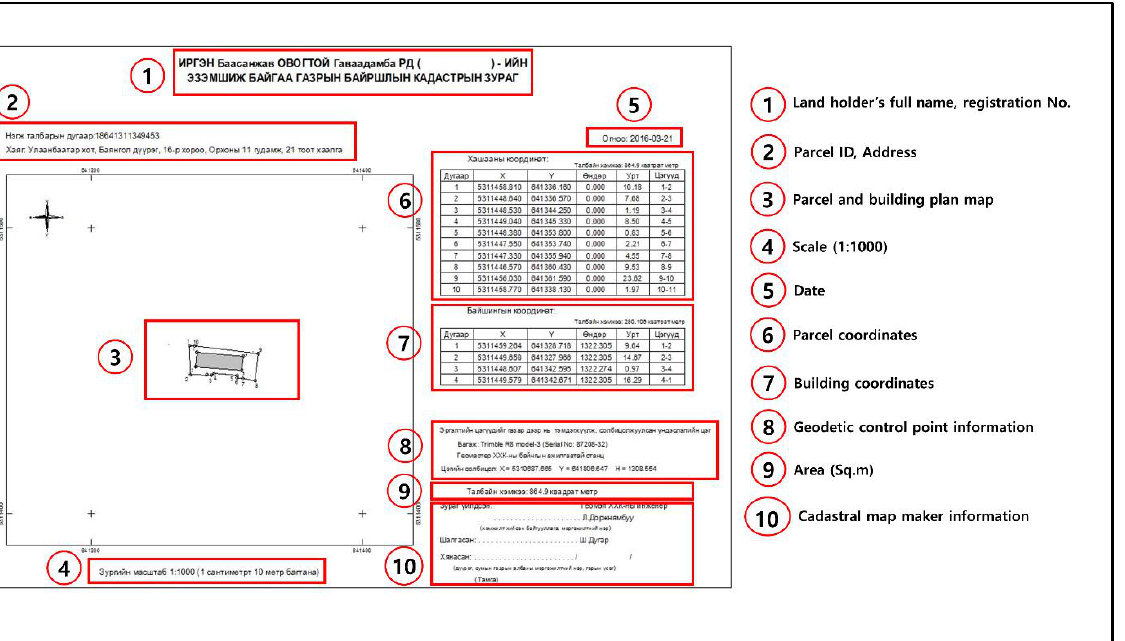
Figure 7. Typical cadastral map of Mongolia.